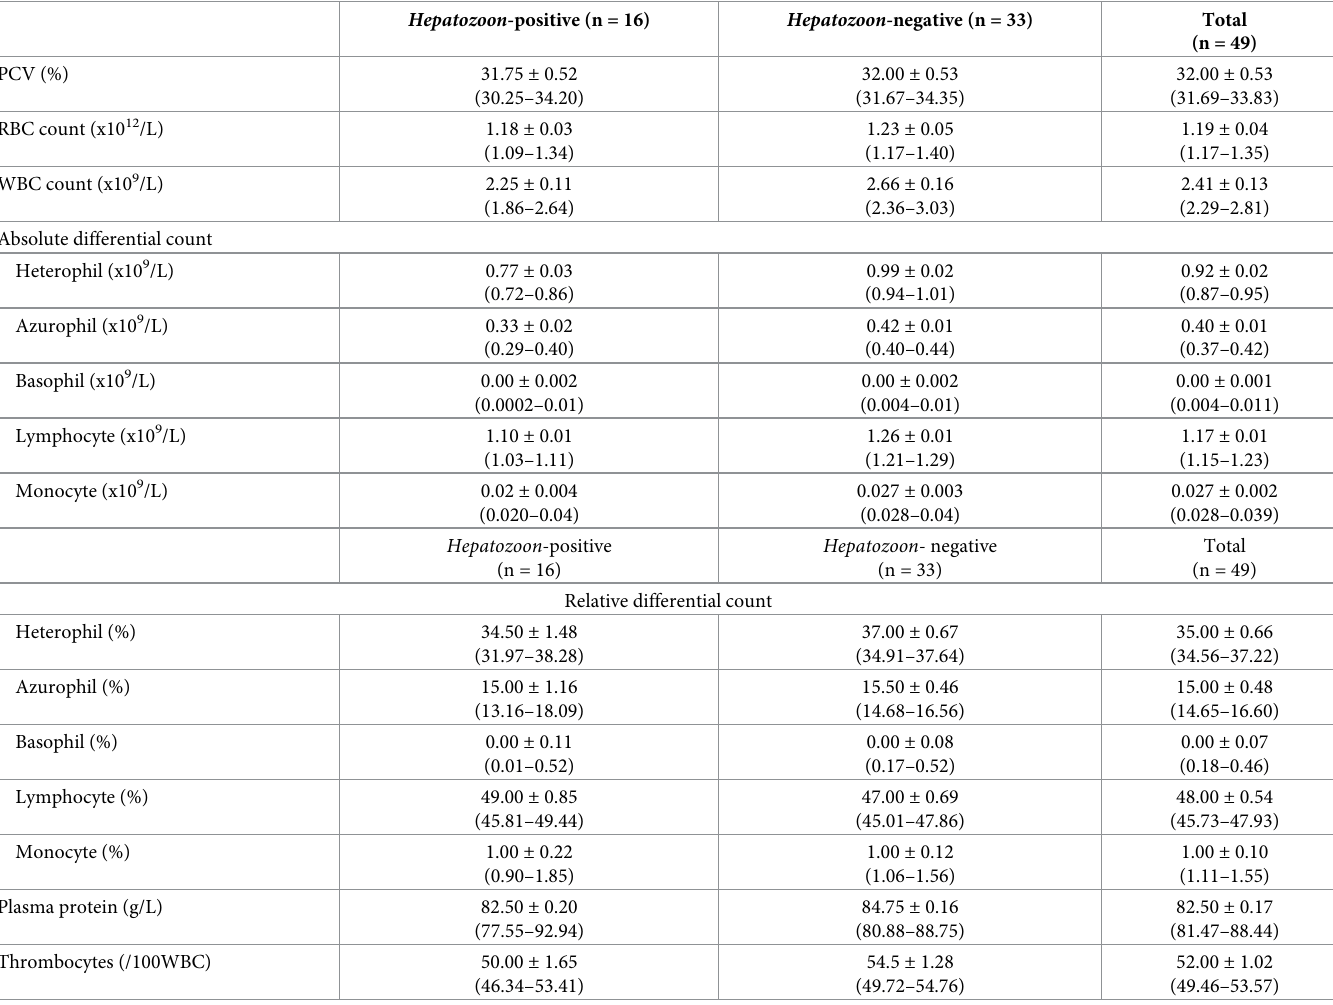
Table 5. Hematological parameters of Asian water monitor comparison between the hepatozoon infection and non-infection (median ± SE and 95% confidence